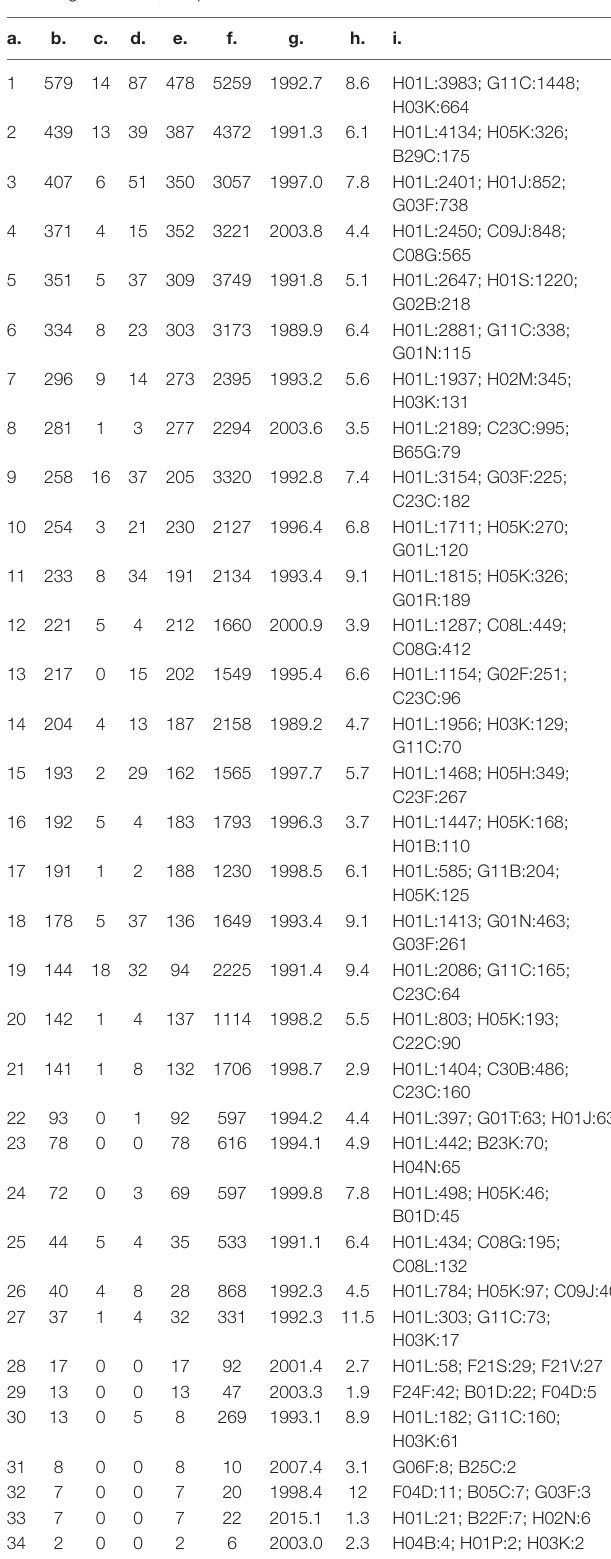
TABLE 3 | Summary of clusters of inventors: a. Cluster number, b. Inventors, c. Star researchers, d. NSR-A1, e. NSR-A2, f. Patents, g. Average Application Year, h. Average Citations, i. Top IPC